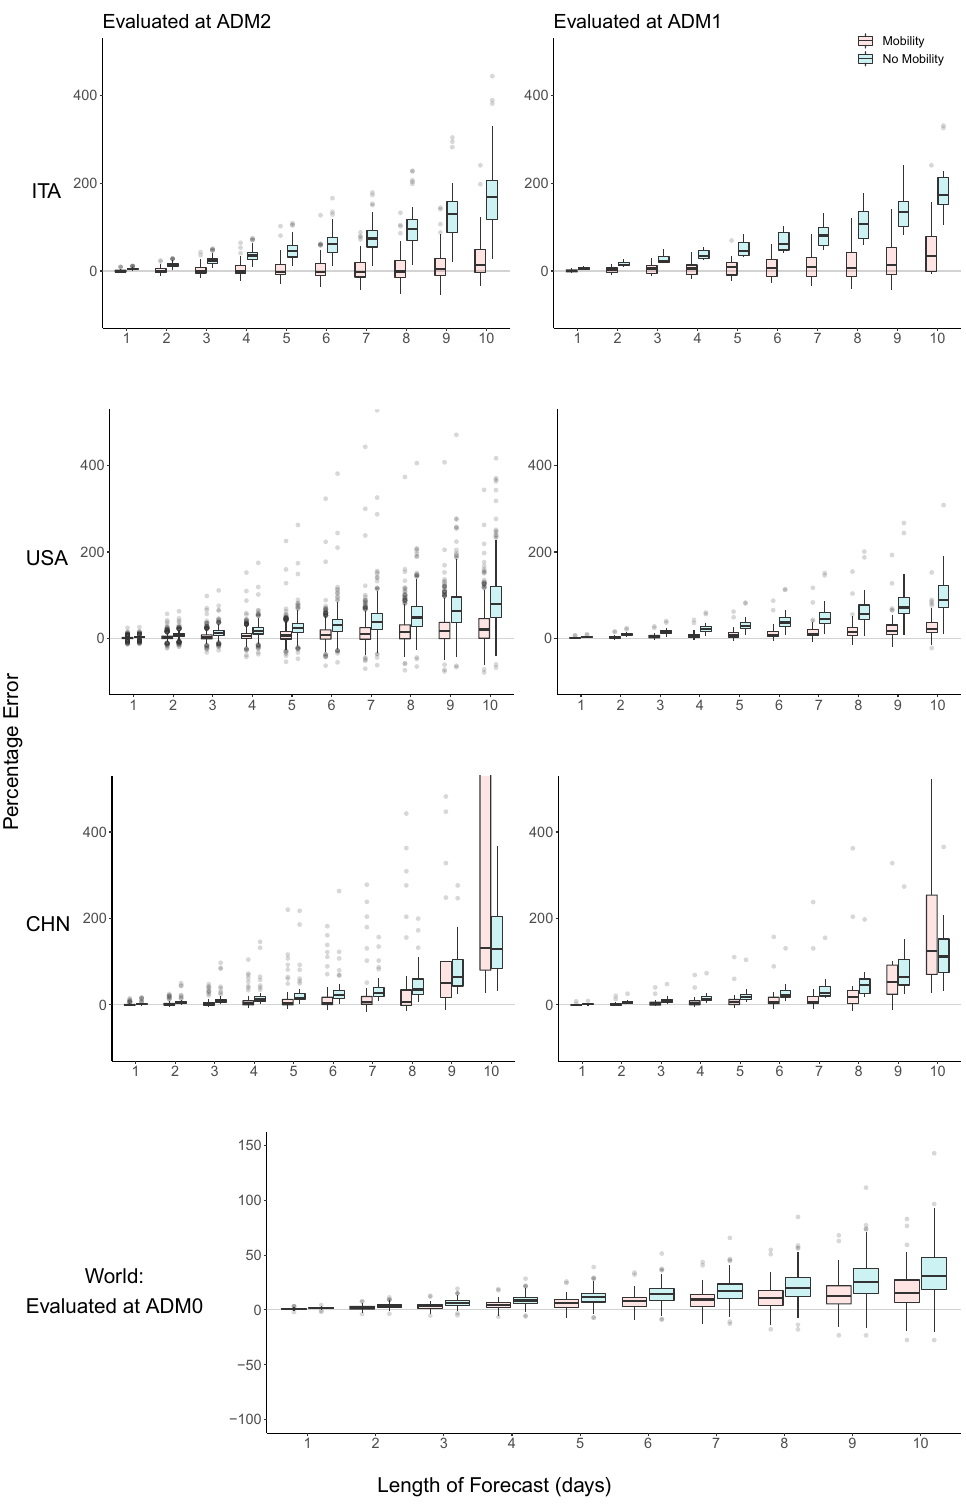
Figure 4. Evaluation of forecast errors for the infection model. For Italy, US and China, forecasts are evaluated at the finest administrative level (ADM2), as well as aggregated to larger regions (ADM1). For each ADM2 region and forecast length, the mean is taken over all available forecast dates, and the error is evaluated using that mean. Boxplots display the distribution of these percentage errors for each ADM2 region. These are then aggregated to ADM1 level (right panel), for both models including and excluding mobility variables. Similarly, for data fitted at a global level (bottom-most plot), for each country and forecast length, the mean is taken over all forecast